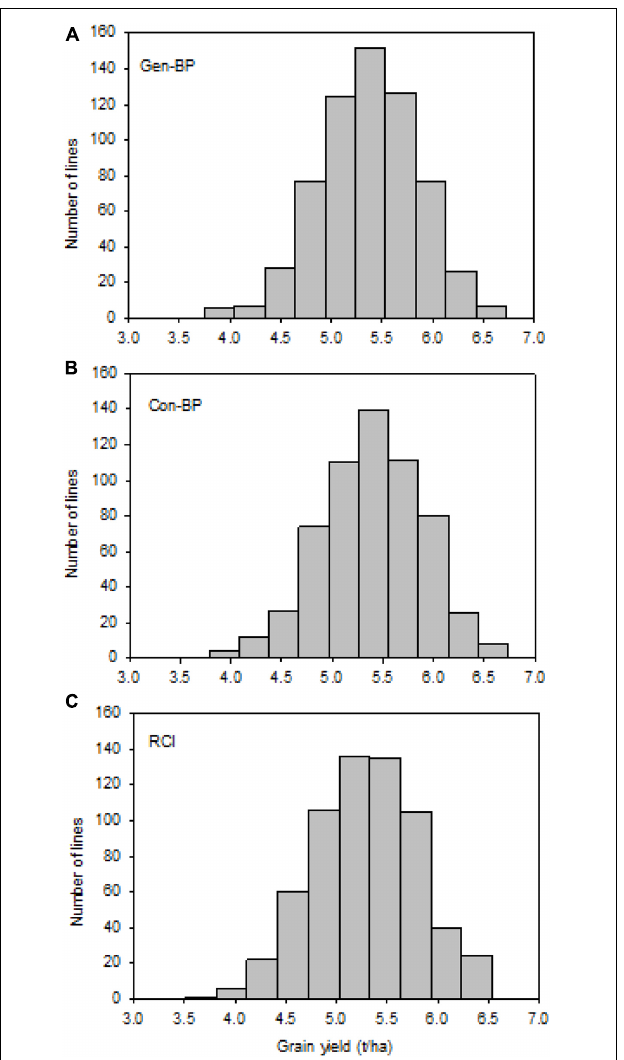
FIGURE 4 | Experiment 1: Distribution of observed grain yield across 2 years under different selection strategies: (A) Gen-BP, (B) Con-BP, and (C) RCI. Con-BPs, conventional biparental populations; Gen-BPs, genomic biparental populations; RCI, rapid cycling intercross.